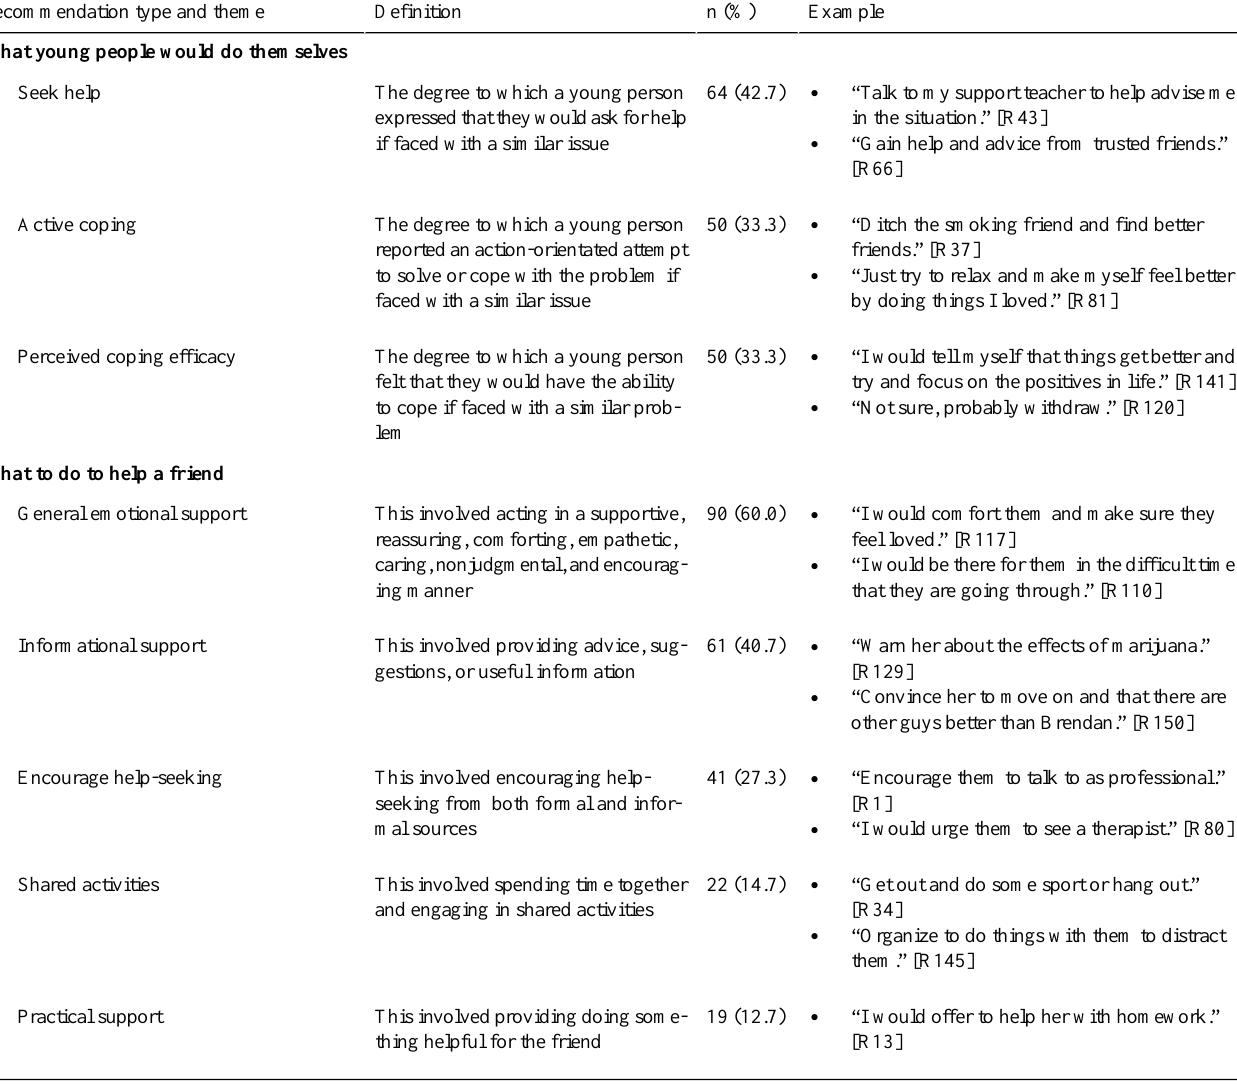
Table 7. Participants’recommendations for what they would do themselves and recommend to a friend when faced with a relationship issue (N=150). R: